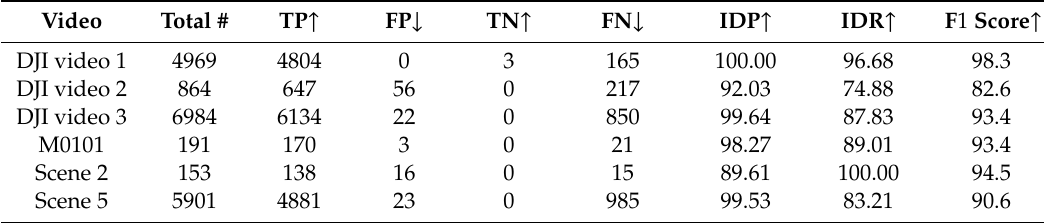
Table 2. The evaluation metrics of multi-vehicle detection from UAV videos.